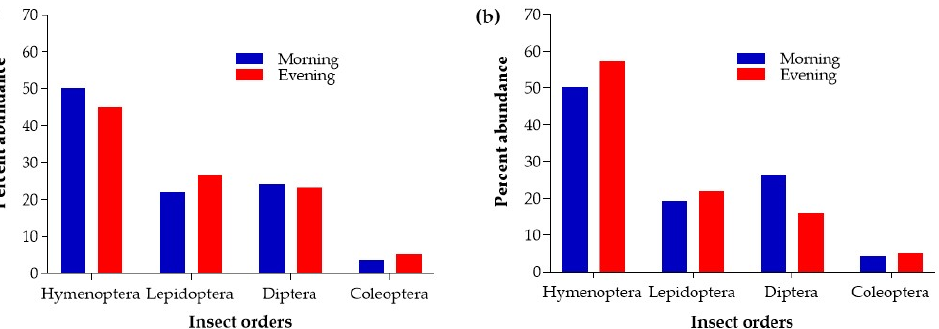
Figure 1. Relative abundance of insect pollinators: ( a ) Field 1 (Natural pollination); ( b ) Field 2 (Natural pollination with one A. mellifera colony).